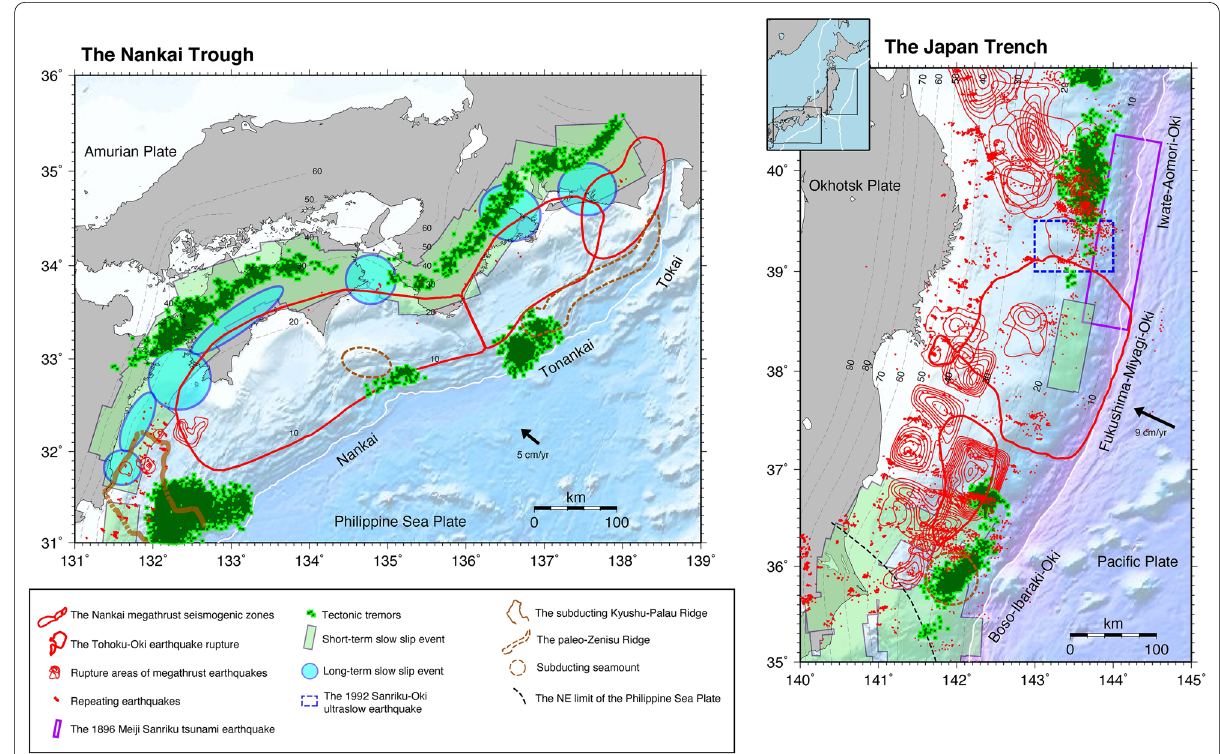
Fig. 1 Distribution of slow and fast earthquakes in the Japan Trench and Nankai Trough. Green and blue symbols semi-schematically show the distribution of slow earthquakes (tectonic tremors, short-term slow slip events, and long-term slow slip events). Red symbols indicate the distribution of fast, regular earthquakes. For an explanation of the other symbols, refer to the legend in the figure. The distribution of slow and fast earthquakes in the Nankai Trough is adapted from Obara and Kato (2016) and Obara (2020). Depth contours of the upper surface of the Pacific and Philippine Sea plates are based on Baba et al. (2002), Nakajima and Hasegawa (2006), Nakajima and Hasegawa (2007), Hirose et al. (2008), Nakajima et al. (2009), and Kita et al. (2010). The slip distributions of the March 11, 2011, Tohoku-Oki earthquake (10 m or larger) and other megathrust earthquakes are from Yagi et al. (1998), Yagi et al. (1999), Nagai et al. (2001), Tanioka and Seno (2001), Murotani et al. (2003), Yamanaka and Kikuchi (2004), Earthquake Research Center (2005), Mochizuki et al. (2008), Research Center for Seismology, Volcanology, and Disaster Mitigation (2008), Iinuma et al. (2012), Ohta et al. (2012), Kubo et al. (2013), and Kubo and Nishikawa (2020). The distribution of small repeating earthquakes is from Uchida and Matsuzawa (2013) and Igarashi (2020). The distribution of tectonic tremors is based on Idehara et al. (2014), Yamashita et al. (2015), Araki et al. (2017), Nishikawa et al. (2019), Yabe et al. (2019), and Yamashita et al. (2021). The distribution of short-term slow slip events is based on Ito et al. (2013), Nishimura et al. (2013), Nishimura (2014), and Nishimura (2021). The source area of the 1992 Sanriku-Oki ultraslow earthquake is from Kawasaki et al. (2001). The locations of subducting ridges and seamounts are based on Kodaira et al. (2000), Park et al. (2004), Mochizuki et al. (2008), and Yamamoto et al. (2013). The northeastern limit of the Philippine Sea Plate is from Uchida et al. (2009a). Seafloor topography is from Smith